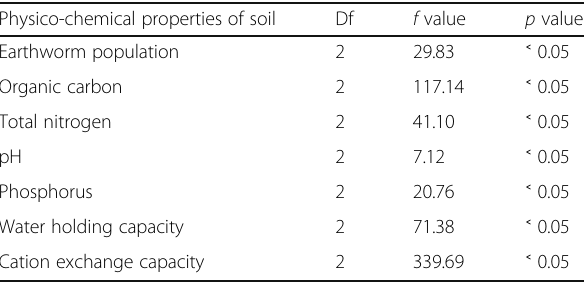
Table 6 Physico-chemical parameters of various land use patterns df: degrees of freedom ANOVA ( n = 5) Physico-chemical properties of soil Df f value p value Earthworm